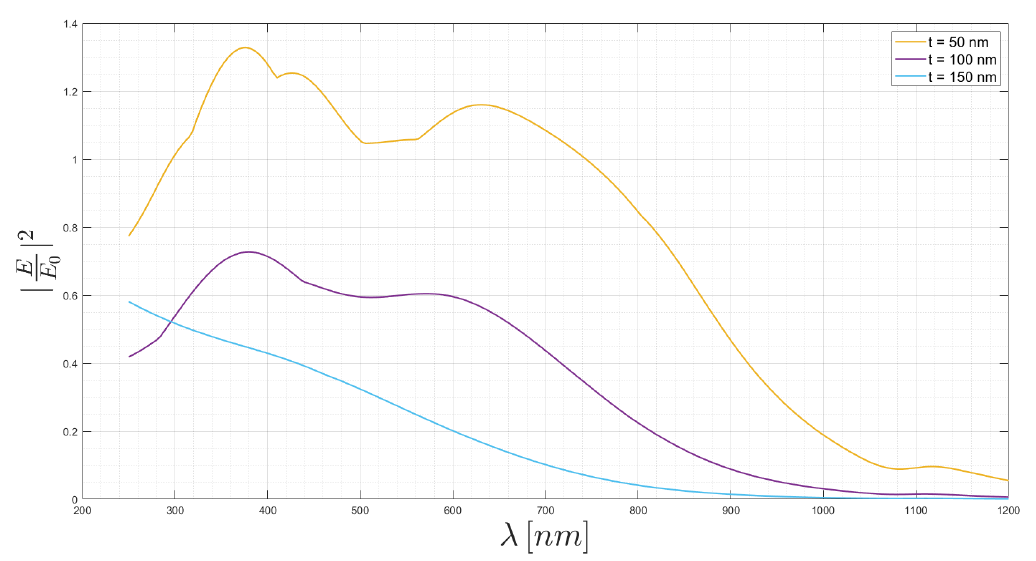
Figure 8. Nanoantenna thickness sweep on an aluminum nanostructure with a quartz